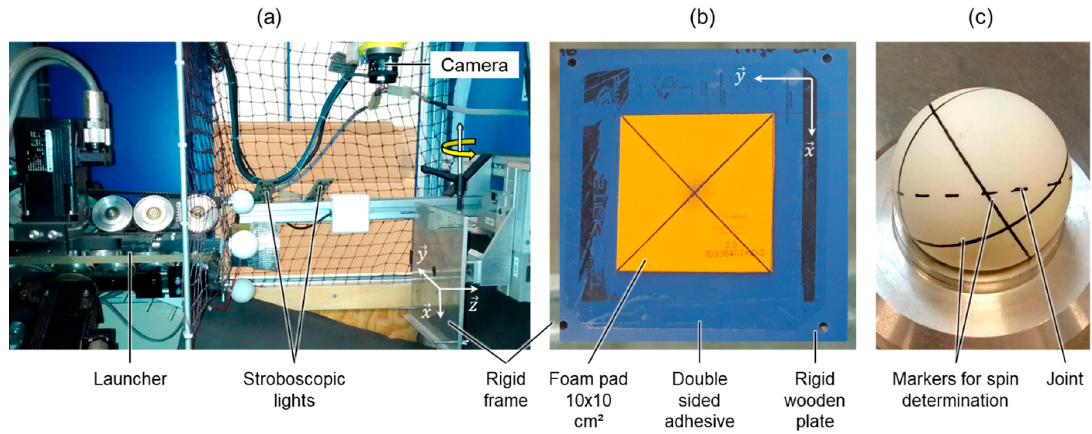
Figure 2. Impact tests. ( a ) Cornilleau home-made apparatus. ( b ) Top view of a foam pad glued onto a wooden plate frame. ( c ) Ball with visual markers